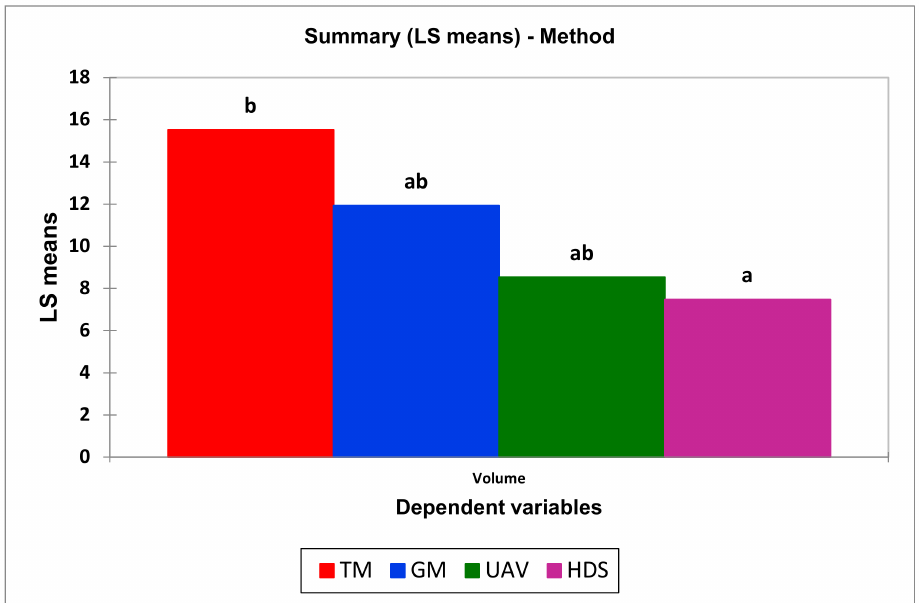
Figure 20. Statistical analysis of the methods used (Bonferroni test). TM (Traditional